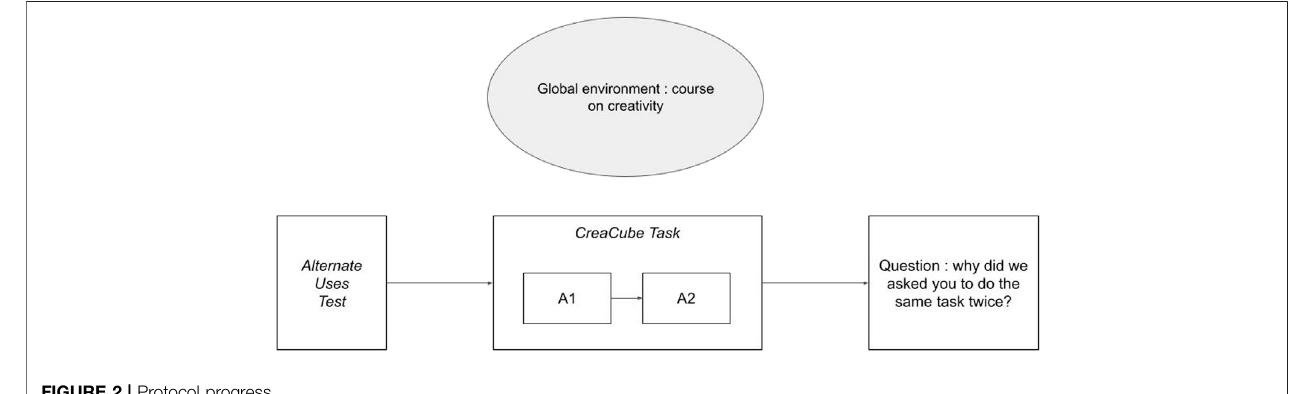
FIGURE 2 | Protocol progress.